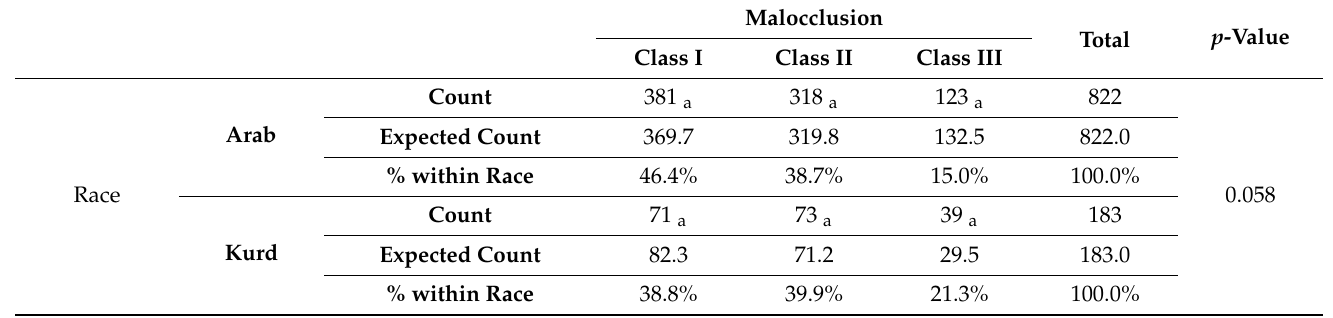
Table 4. Descriptive statistics and comparison of malocclusions distribution (chi-square